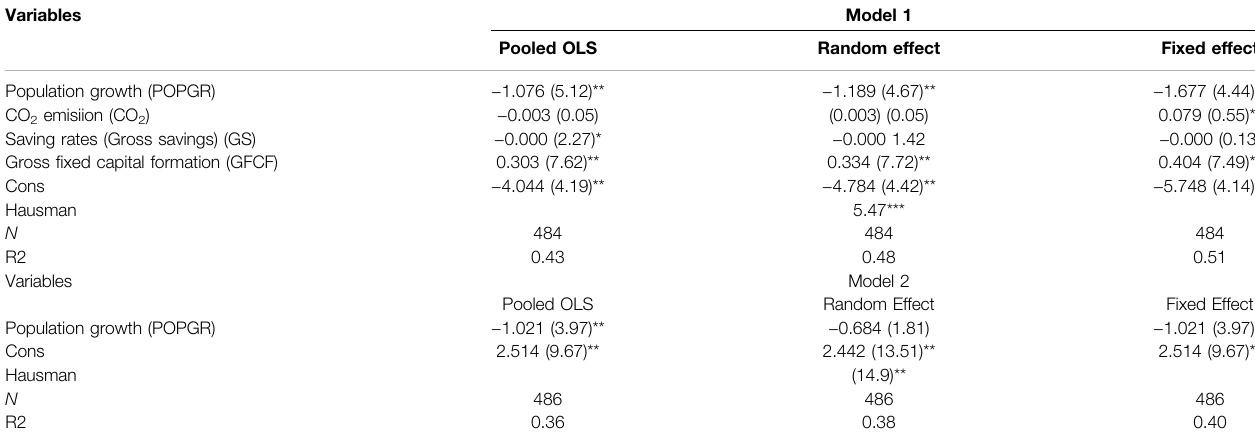
TABLE 7 | The results of mixed-effect